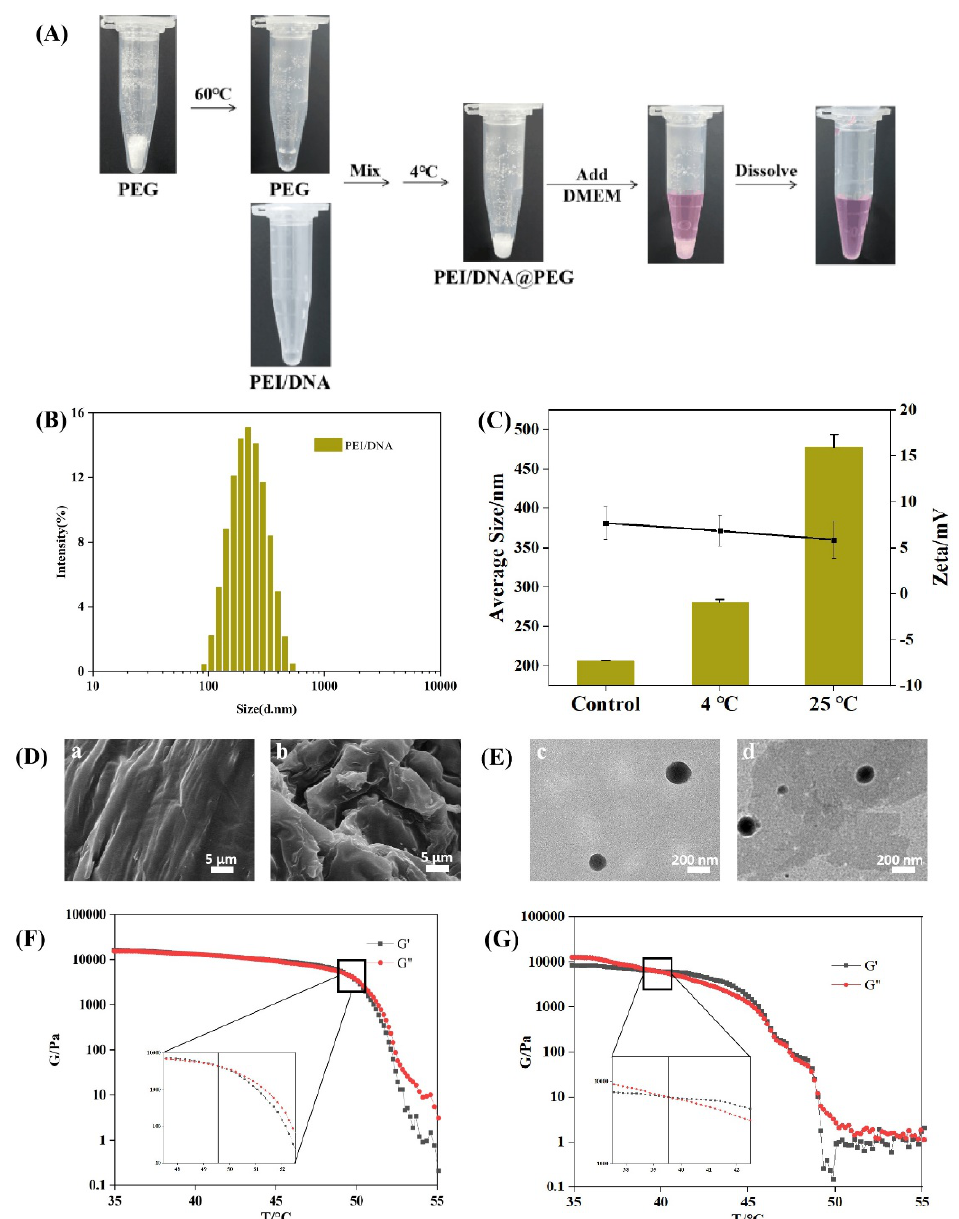
Figure 2. Synthesis and characterization of PEI/DNA@PEG. ( A ) Preparation process of gelled PEI/DNA (PEI/DNA@PEG). ( B ) Particle size of PEI/DNA complex. ( C ) Size stability of PEI/DNA nanoparticles at 4 °C and 25 °C for 3 days was determined by DLS. ( n = 3) ( D ) SEM of ( a ) PEG, ( b ) PEI/DNA@PEG. ( E )TEM of ( c ) PEI/DNA. ( d ) PEI/DNA@PEG (aqueous solution). Melting point of PEG ( F ) and PEI/DNA@PEG ( G ).